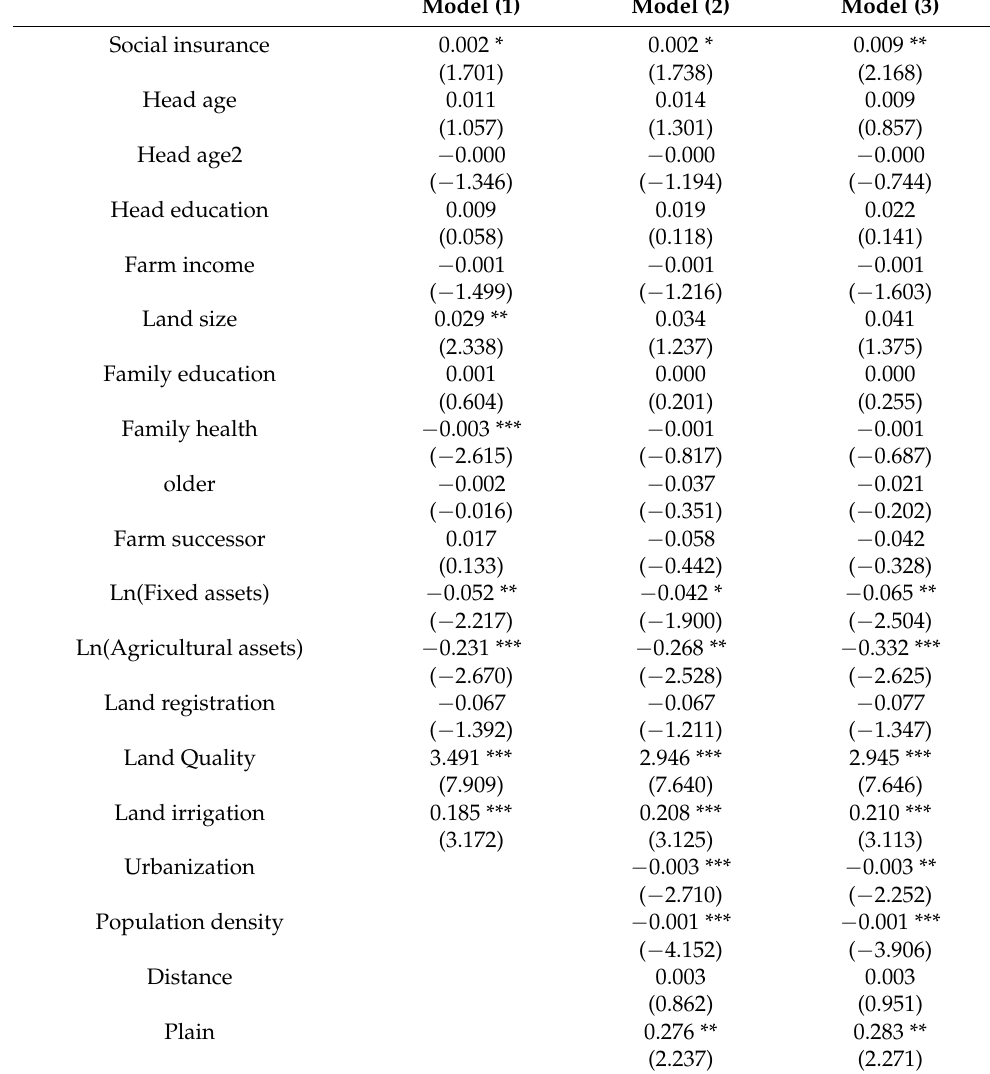
Table 2. The estimates of impacts of institutional social insurance on cultivated land